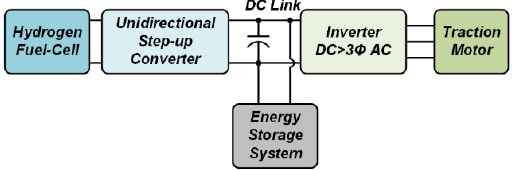
Figure 1. System configuration of the fuel-cell hybrid railroad vehicle propulsion